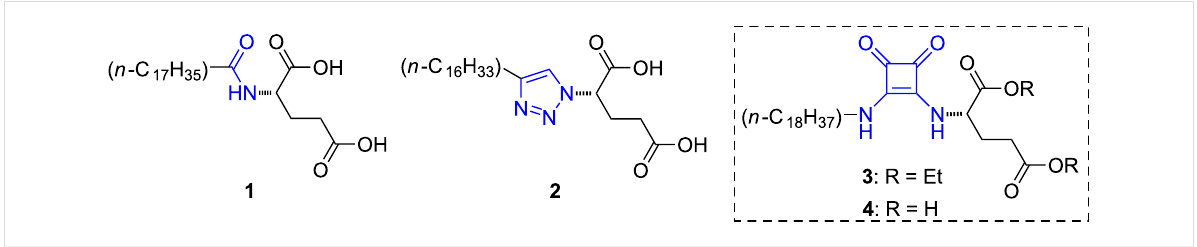
Figure 1: Chemical structures of isosteric gelators 1 and 2 previously studied [33], and squaramide-based analogues 3 and 4 investigated in this